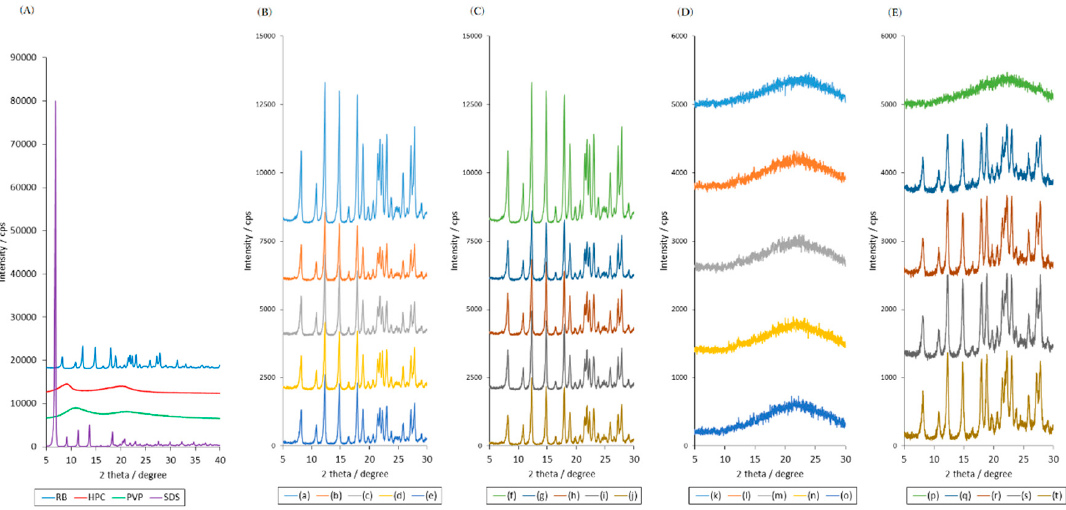
Figure 2. PXRD pattern of bulk materials ( A ) and stored samples ( B – E ). RB form I PM sample stored in RH 30% ( B ) and RH 75% ( C ). Amorphous RB sample stored in RH 30% ( D ) and RH 75% ( E ). Storage